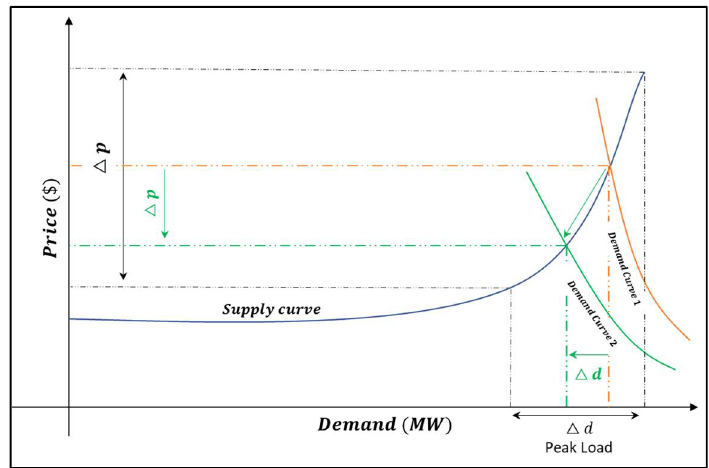
Figure 2. Standard supply–demand curve of electrical energy markets.